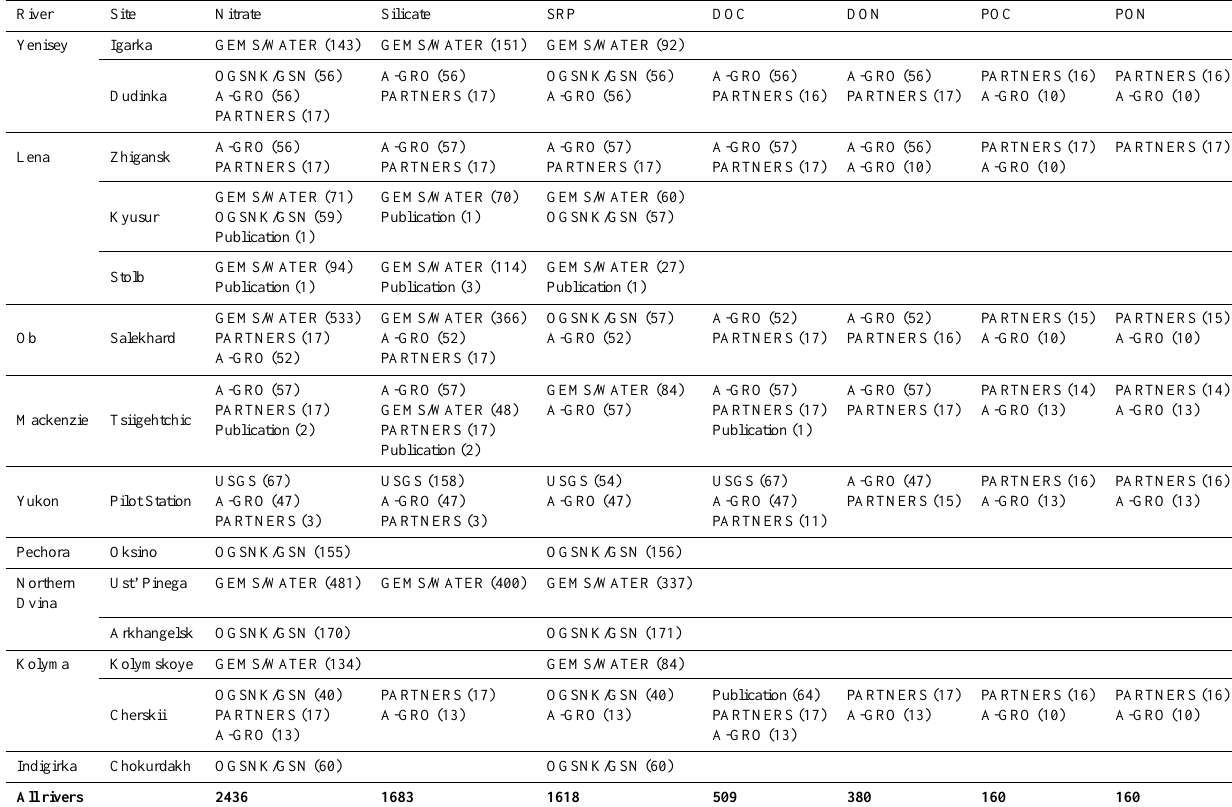
Table 1. Data sets of nitrate, silicate, SRP, DOC, DON, POC and PON concentration used for each river sampling location. The number of data for each data set is given between